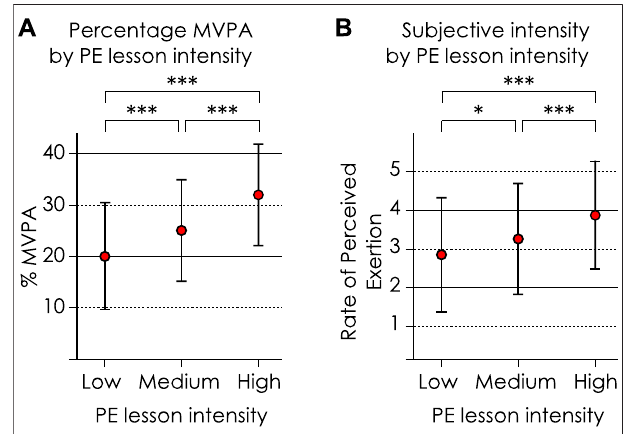
FIGURE1| DifferenceinobjectiveandsubjectiveintensityofPElessons. (A) Percentage MVPA by PE lesson Intensity (B) Subjective intensity by PE lesson intensity. Note. PE (cid:1) Physical education. MVPA (cid:1) Moderate-to- vigorous physical activity. * p ≤ 0.05, ** p ≤ 0.01, and *** p ≤